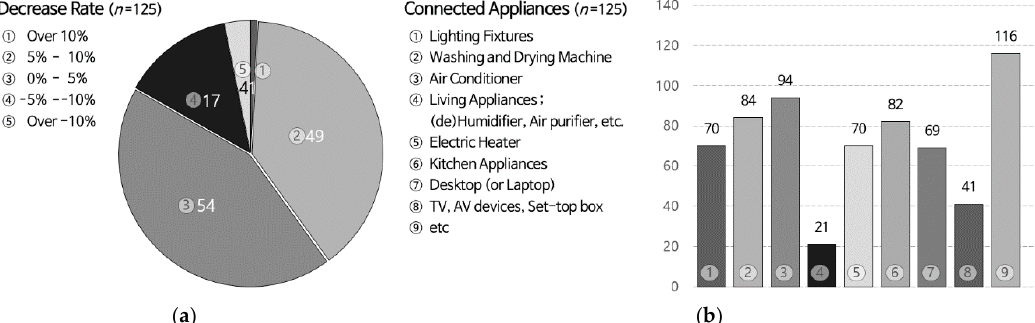
Figure 1. Result of electric power decrease rate of the program participants for 15 months compared to: ( a ) the same month last year; ( b ) connected appliances with smart plugs and switches.